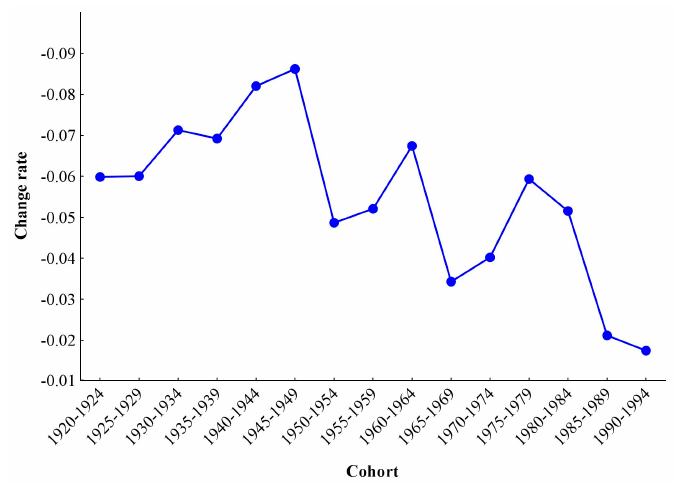
Figure 8. Change rate of cohort effects on stroke mortality PM-2.5 in China.